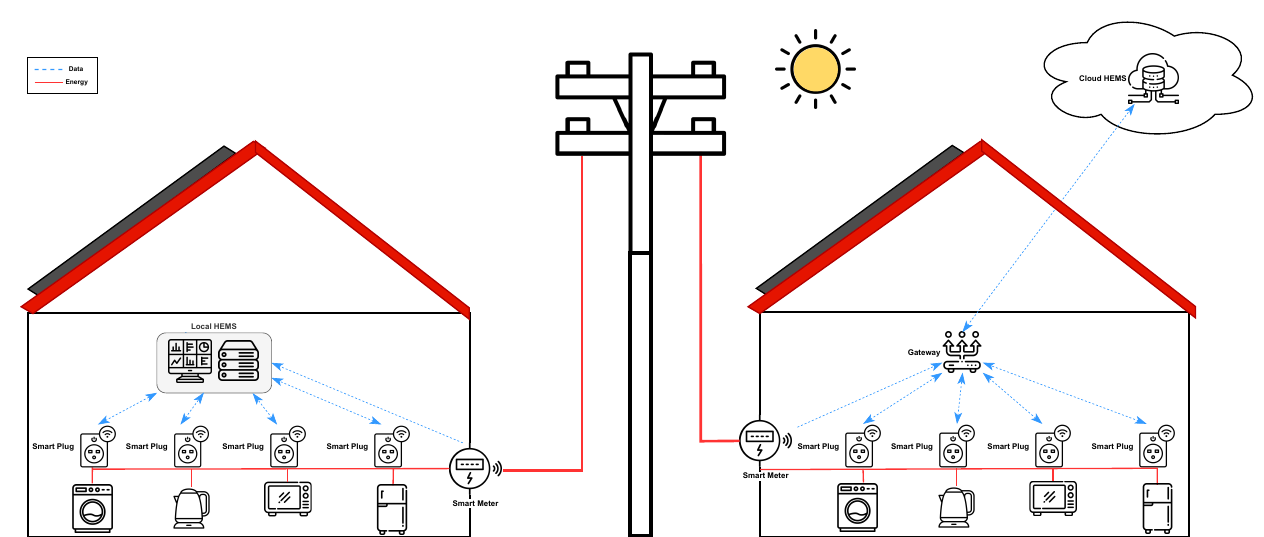
Figure 2. Schematic diagram for HEMS. Left : Local HEMS design, Right : Cloud HEMS design. The design of the Cloud-IoT HEMS is presented on the right side of Figure 2, where the energy and data interactions are shown. Smart meters and smart plugs allow the collection of energy-related data. The main objective is to send the energy consumption data to the cloud. For this purpose, the things send information to a gateway, which allows bridging the data into the